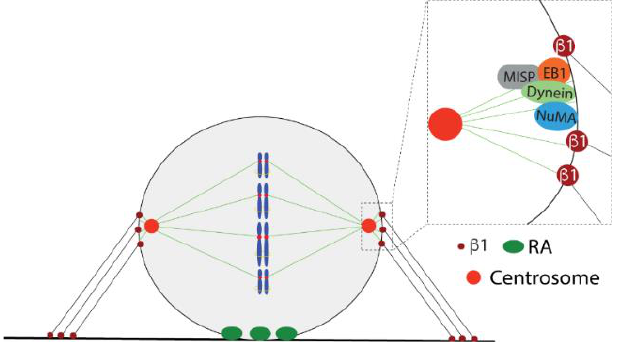
Figure 5. The schematic picture demonstrates the spindle orientation and some of the microtubule- and retraction fiber-associated proteins.